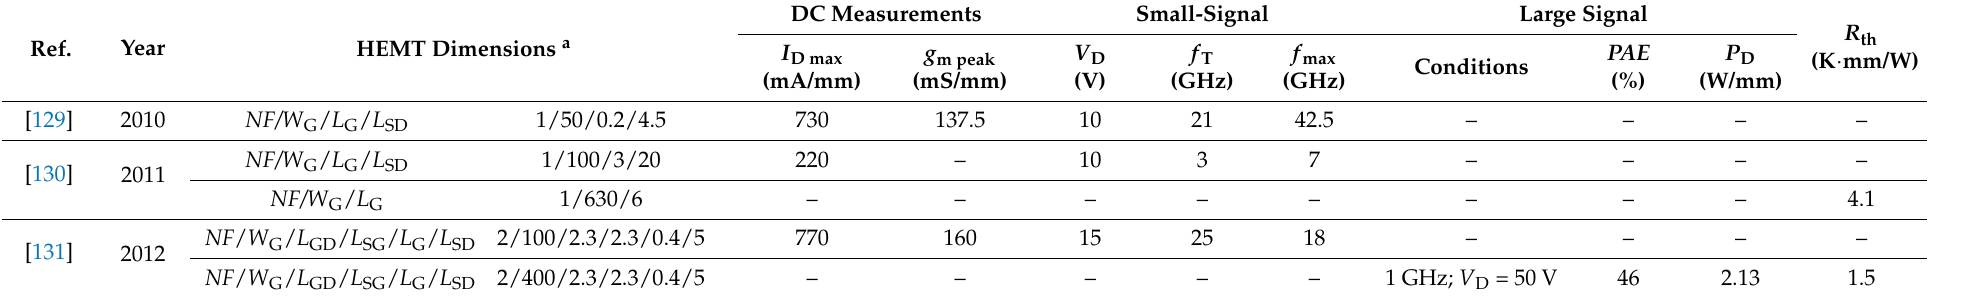
Table A3. Relevant electrical parameters of HEMTs fabricated on GaN layers deposited on diamond substrates.